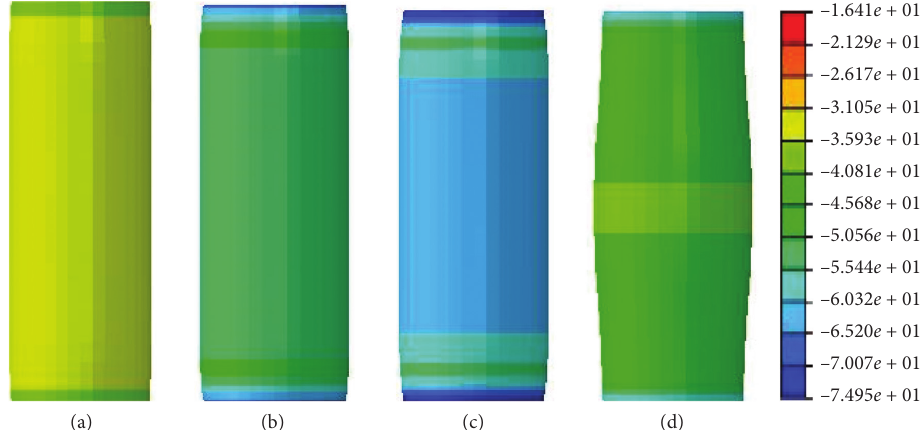
Figure 8: The longitudinal stress contour maps of the core concrete. (a) Point A. (b) Point B. (c) Point C. (d) Point D.